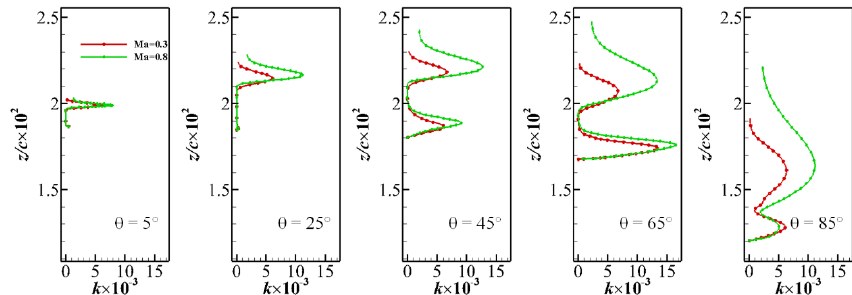
Figure 17. Turbulent kinetic energy at specific locations for NPR =